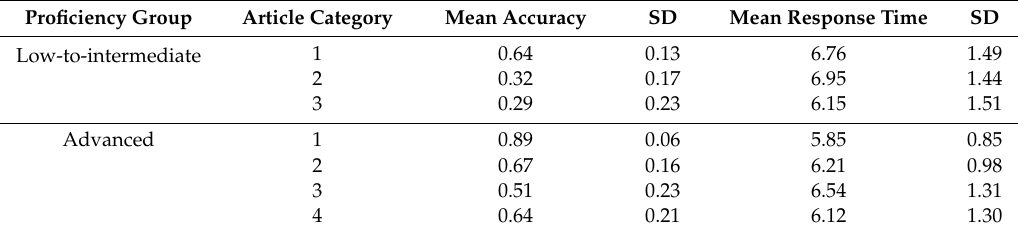
Table 4. Mean accuracy and response time of usage-based